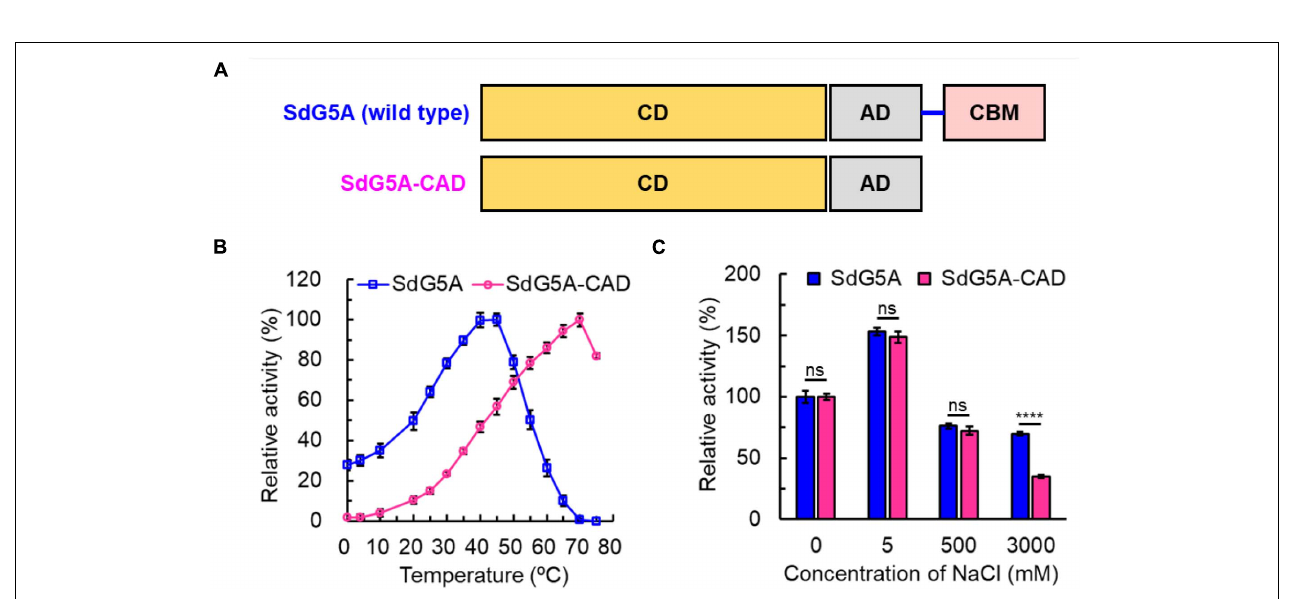
FIGURE 6 | Characterization of SdG5A-CAD. (A) Schematic of truncation of the linker-CBM region of SdG5A. (B) Effect of temperature on the activity. The temperature profile was determined in C 4 H 2 O 7 –Na 2 HPO 4 buffer (pH 6.5) at different temperatures ranging from 0 to 75 ◦ C. (C) Effect of NaCl concentrations on the activity. The activity of the enzyme with no addition was defined as 100%. Each value represents the mean of three independent measurements (mean ± standard derivation).